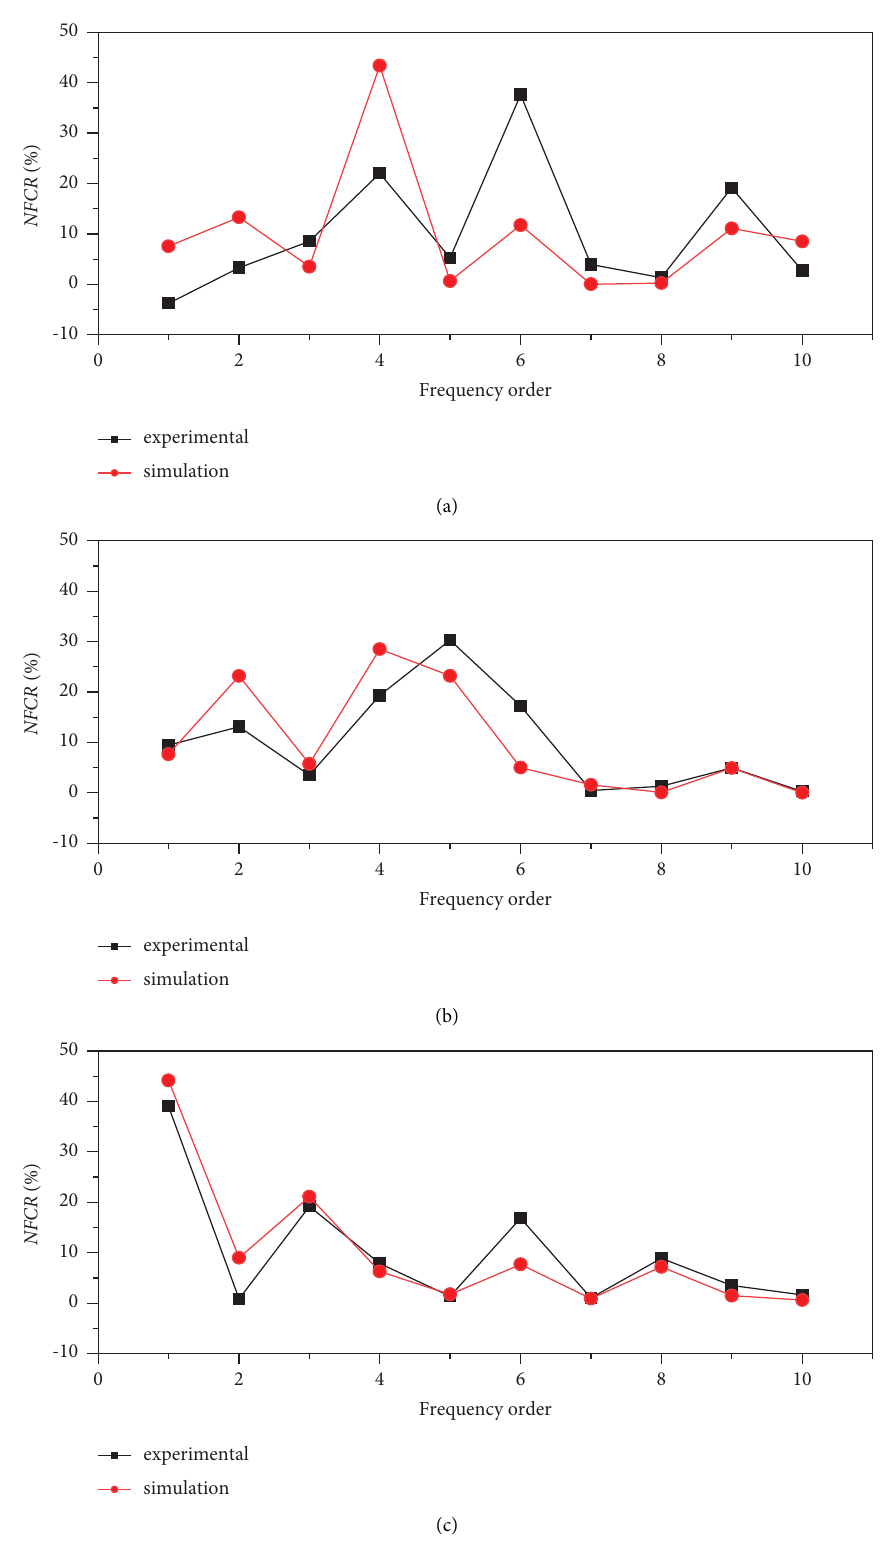
Figure 15: Comparison of the simulation and measured normalized frequency change rates (NFCRs): (a) model 2, (b) model 3, and (c) model